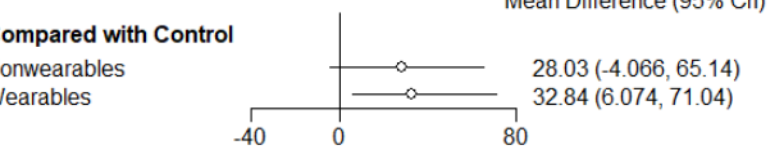
Figure 3. Forest plots of the two intervention strategies suggested a significant improvement of walking distance change score (reported as 6MWD and MWD) in participants who used wearables compared to control group. Results are expressed as mean difference (95% CrI) in metres. Crl: Credible interval. 6MWD—Six-minute walking distance; MWD—Maximum walking distance.